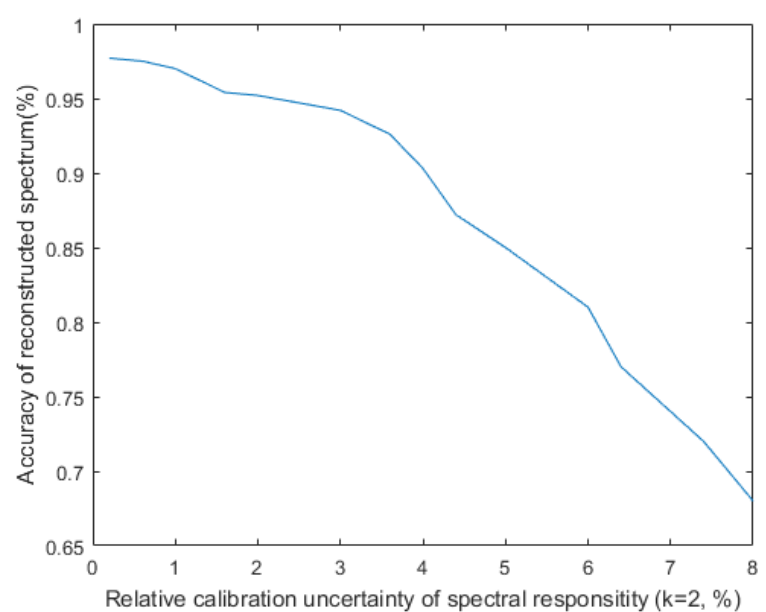
Figure 10. Effect of the calibration uncertainty σ of R on the accuracy of reconstructed spectra.